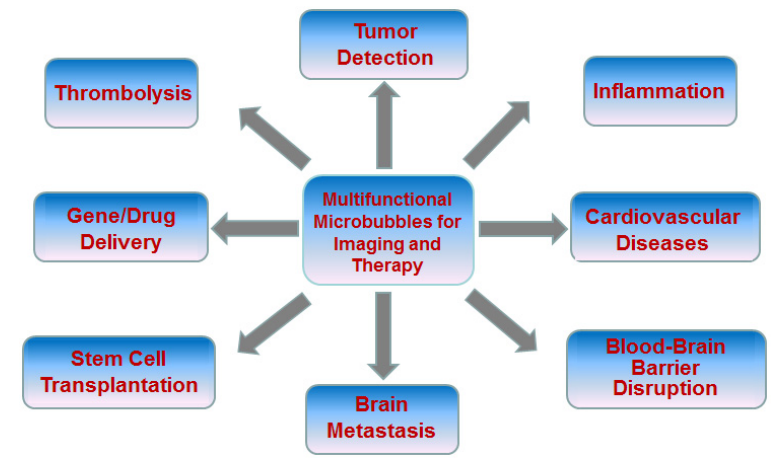
Figure 1. Arena of UCAs (ultrasound contrast agents) as a multifunctional platform combining imaging and therapy.